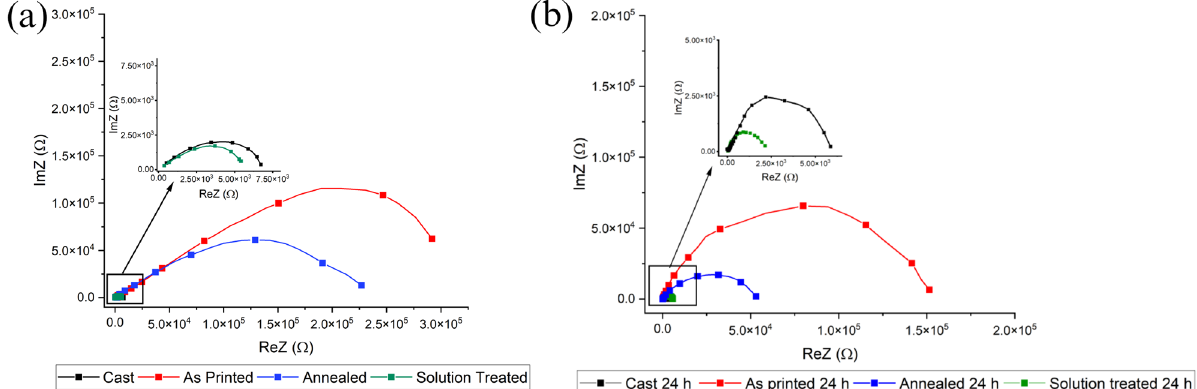
Figure 14. Results of the EIS tests, in term of Nyquist plots, for the different PEO coated samples after 0 h of immersion ( a ) and after 24 h of immersion ( b ). At the high left a zoom of the zone of the graph highlighted by black box. Test Electrolyte: 0.1 M Na 2 SO 4 and 0.05 M NaCl.